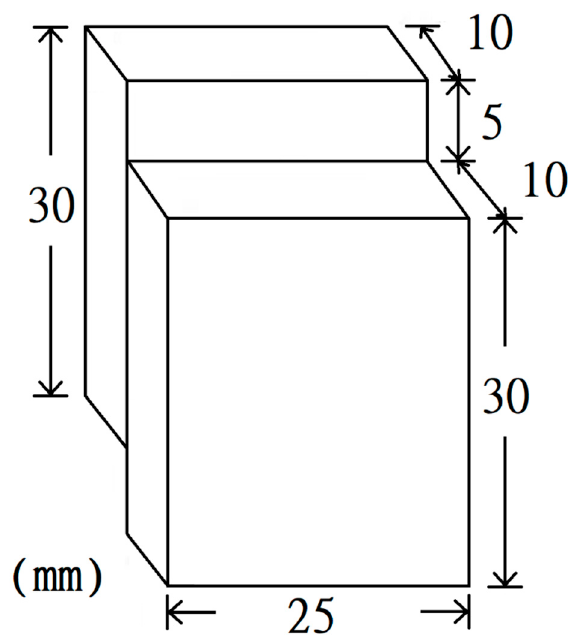
Figure 2. Dimension of testing sample for the compression shear bonding strength test.